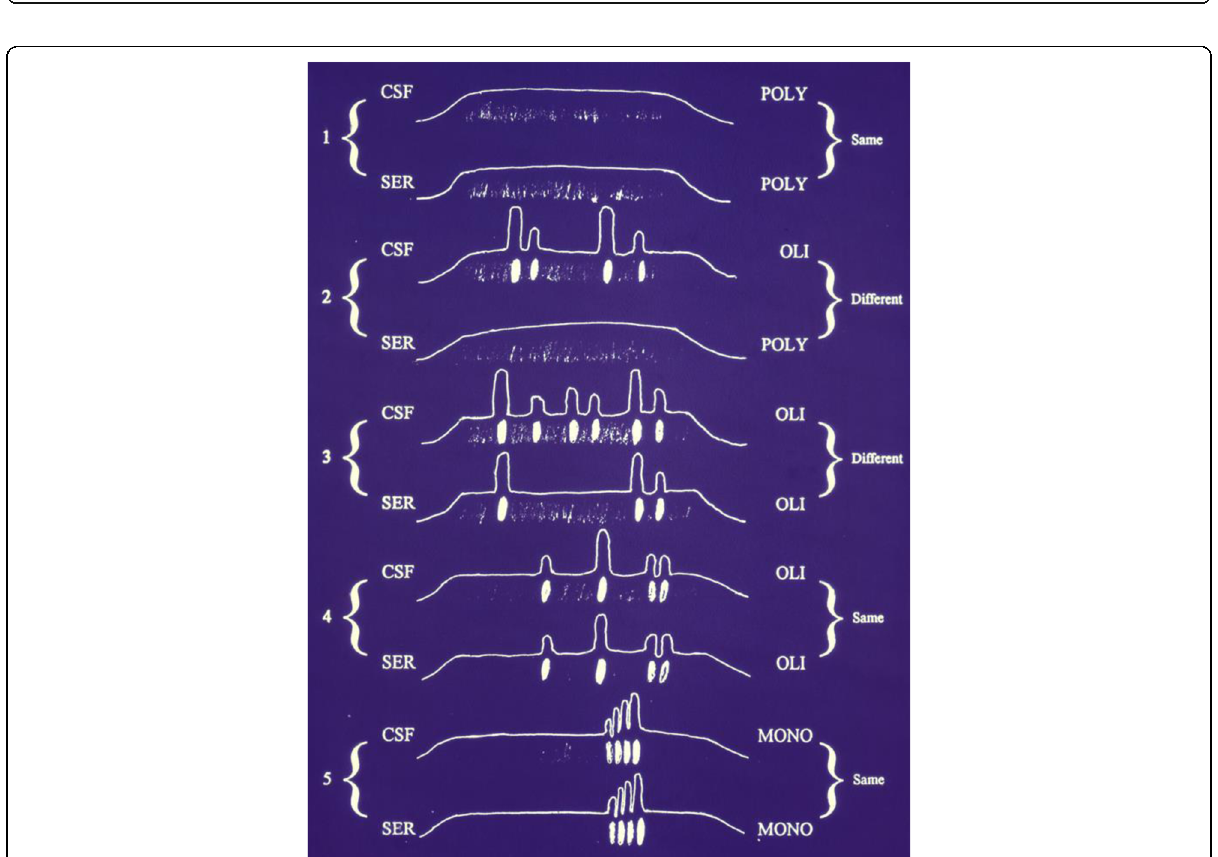
Fig. 3 IgG band patterns. Five different patterns can be found, with patterns 2 and 3 indicating intrathecal synthesis, as shown in Fig. 3: Type 1: Normal finding. Type 2: Isolated OCB in the CSF. Type 3: Identical OCB in cerebrospinal fluid and serum, additionally isolated OCB in the CSF. Type 4: OCB with identical (mirror image) distribution in the CSF and serum. Type 5: Monoclonal bands (usually identical distribution in the CSF and serum) as an indication of systemic gammopathy [51]